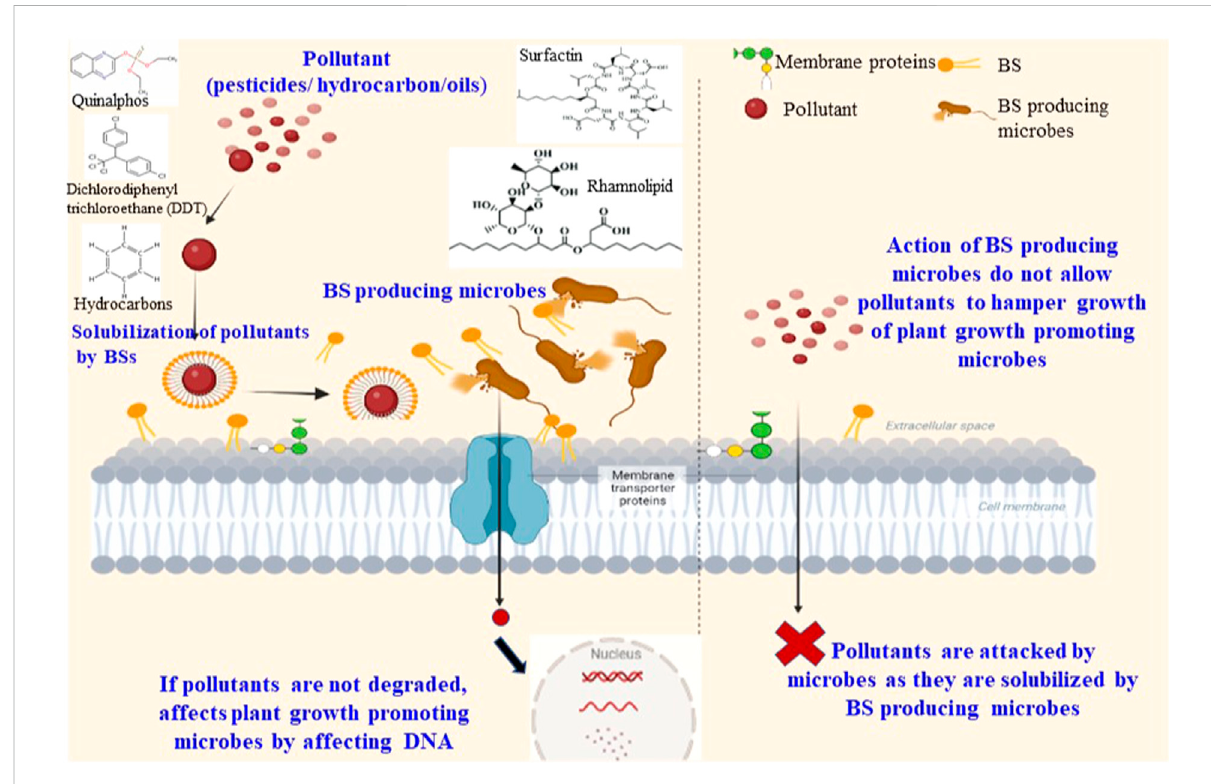
FIGURE 3 Mechanistic action of biosurfactants (BSs) on pollutant/s (pesticides, hydrocarbons, and crude